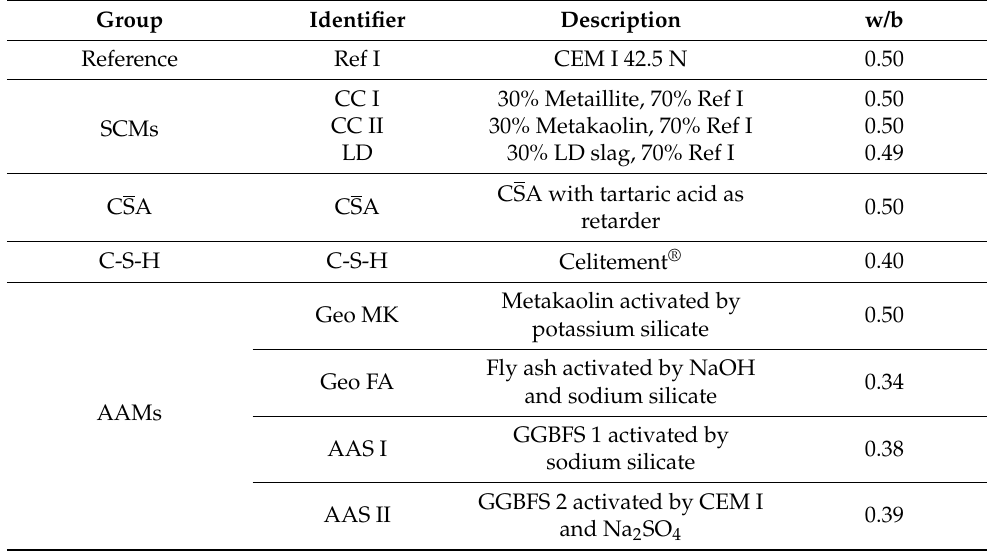
Table 1. Overview of the binders investigated and w/b ratios.